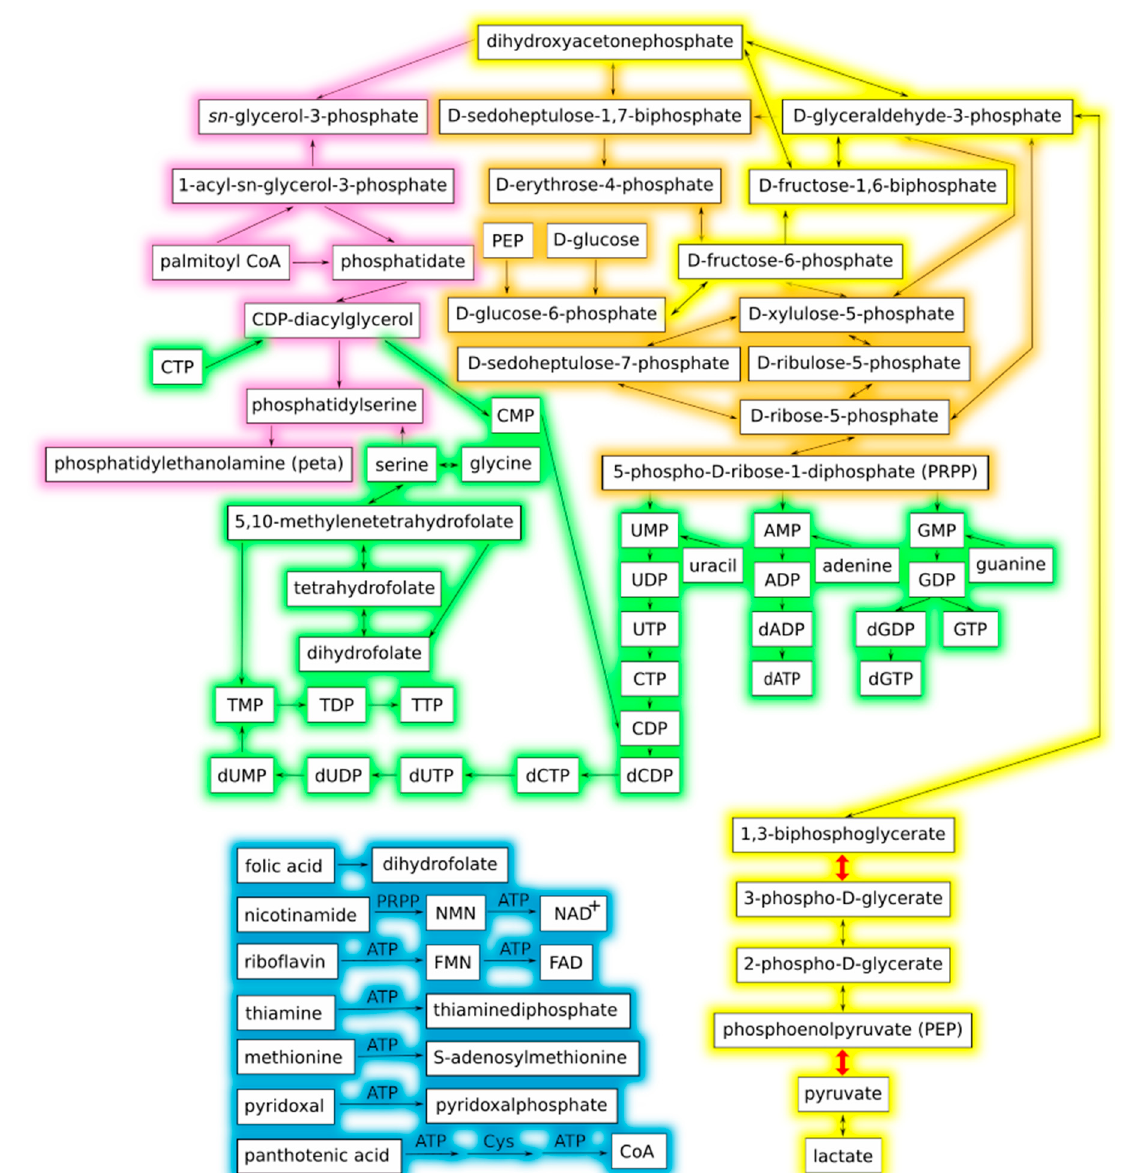
Figure 1. Interaction graph of the proposed theoretical minimal metabolic network adapted from Gabaldón et al. (2007) [19]. Line colors denote metabolic categories: yellow, glycolysis; orange, pentose phosphate pathway; pink, phospholipid metabolism; green, nucleotide metabolism; blue, coenzyme metabolism. The two glycolytic steps in which ATP is produced by substrate ‐ level phosphorylation are depicted with thicker red arrows, and correspond to reactions R01512 and R00200 in Table 1. The reaction graph of this same network is presented in Figure 2 for comparison.